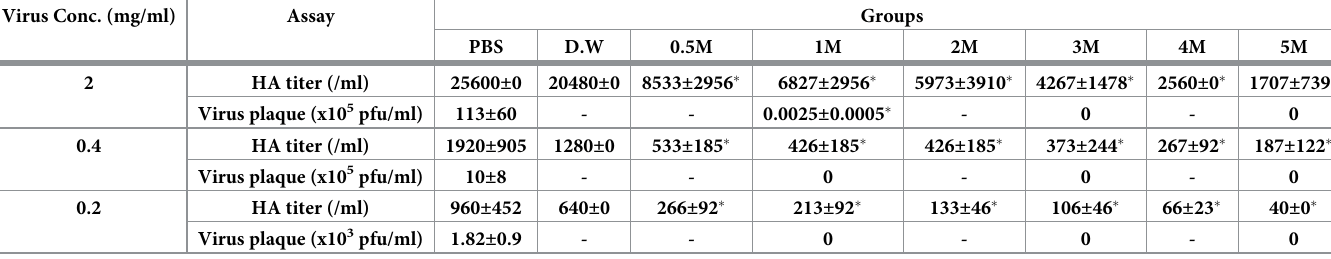
Table 1. HA activity and infectivity of viruses in various concentrations of sodium dihydrogen phosphate. Virus Conc. (mg/ml)